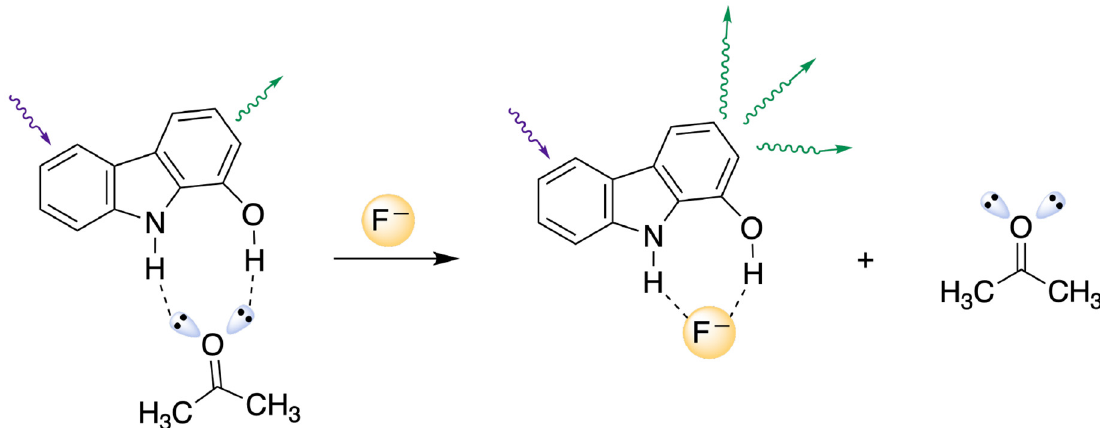
Figure 5. Proposed scheme for the selective sensing of a fluoride anion by compound 2c . The increase in the fluorescence intensity of the sensor is a consequence of charge transfer and the intermolecular sensor–solvent–halide anion